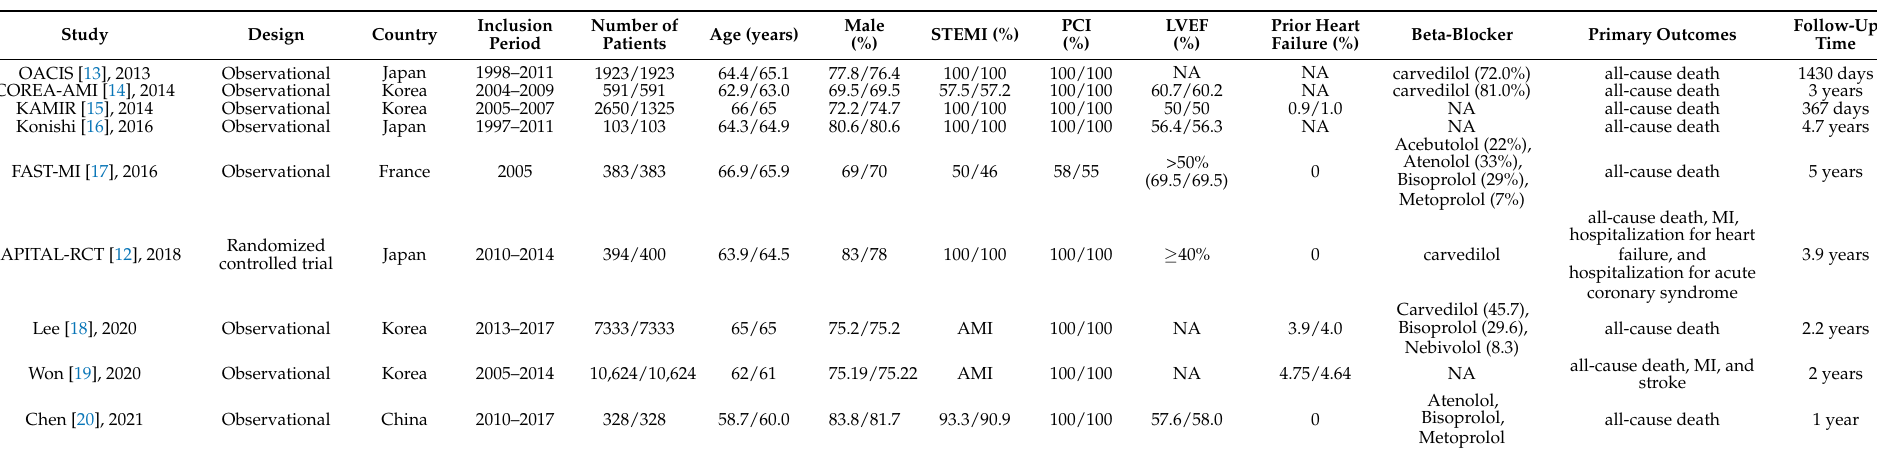
Table 1. Baseline Characteristics of Included Studies and